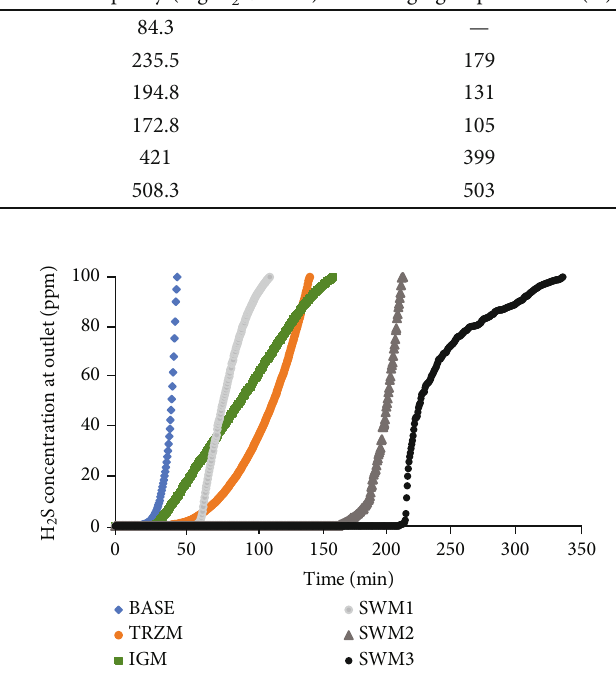
Figure 2: The H S concentration in the outlet gas stream as a 2 function of